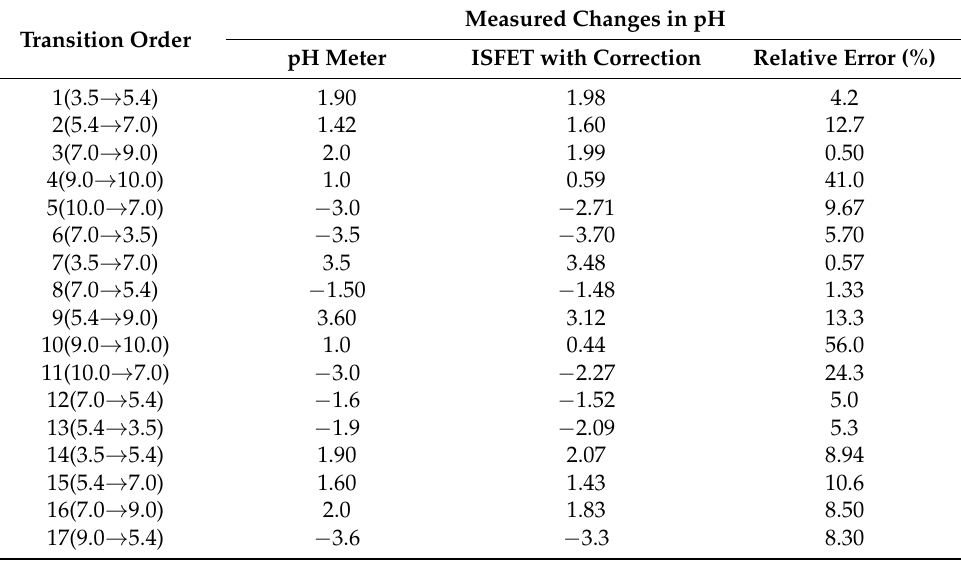
Table 1. Comparison of Measured Changes in